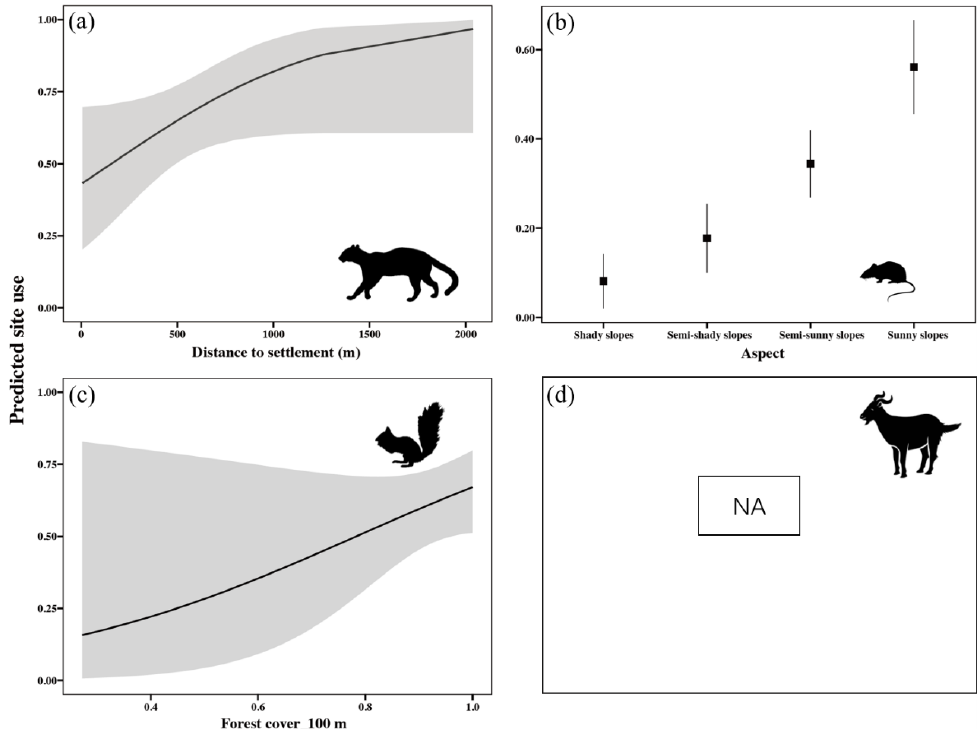
Figure 4. Predictions of the most important covariates influencing the site-use of leopard cats and their prey based on β estimates (solid line), along with their 95% confident intervals (grey shading), from each species’ most supported single-species model (( a ) for leopard cat, ( b ) for nocturnal rats, and ( c ) for diurnal squirrels). The most supported occupancy model for livestock was the null model ( d ).